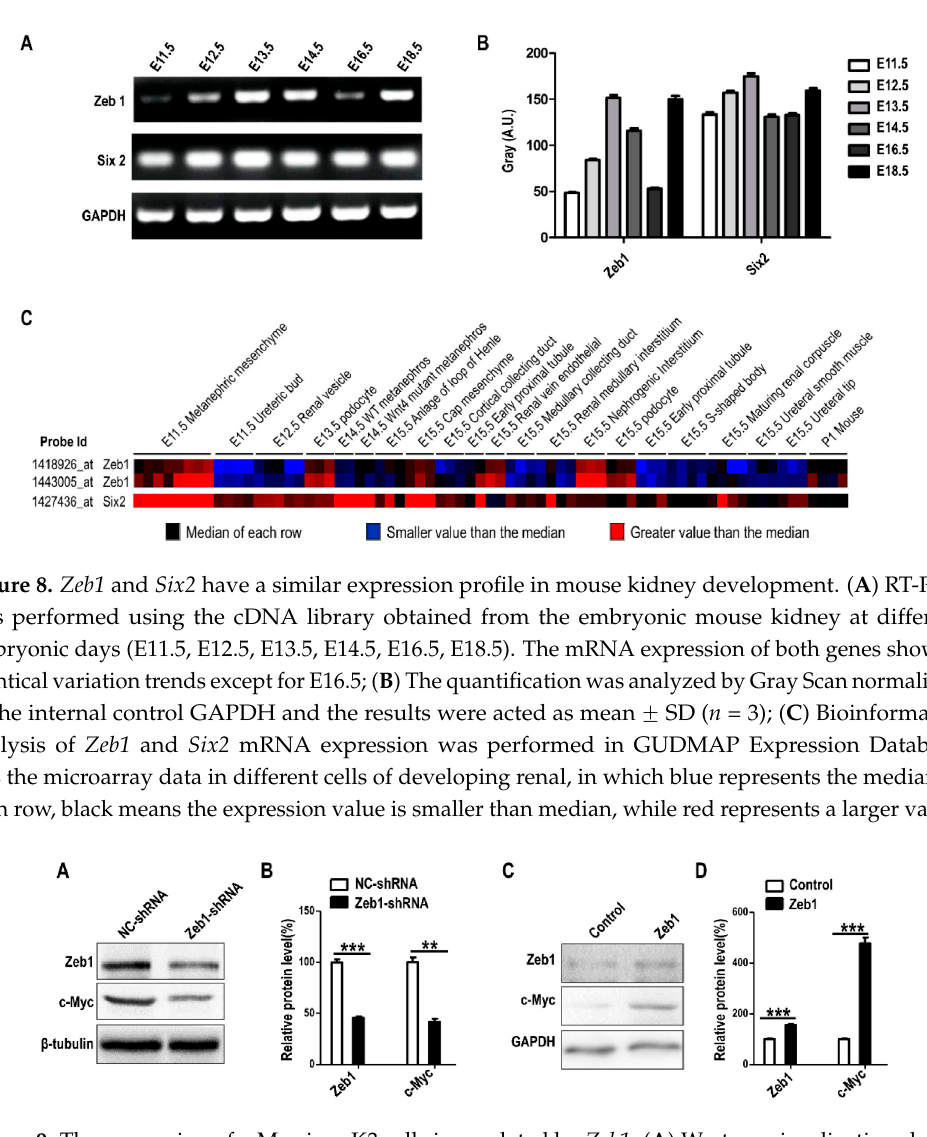
Figure 9. The expression of c-Myc in mK3 cells is regulated by Zeb1 . ( A ) Western visualization shows that mK3 cells introduced with Zeb1 -shRNA for 48 h expressed c-Myc less than cells treated with control shRNA at protein level; ( B ) The expression was calculated by scanning gray in Image J software normalized to the internal control GAPDH. The result was displayed with error bars representing mean ± SD ( n = 3). ** p < 0.01, *** p <0.001; ( C ) The protein expression of c-Myc was increased in mK3 cells treated with Zeb1 overexpression for 48 h compared with the control cells (blank vector); ( D ) The expression was quantified the same way as in ( B ).